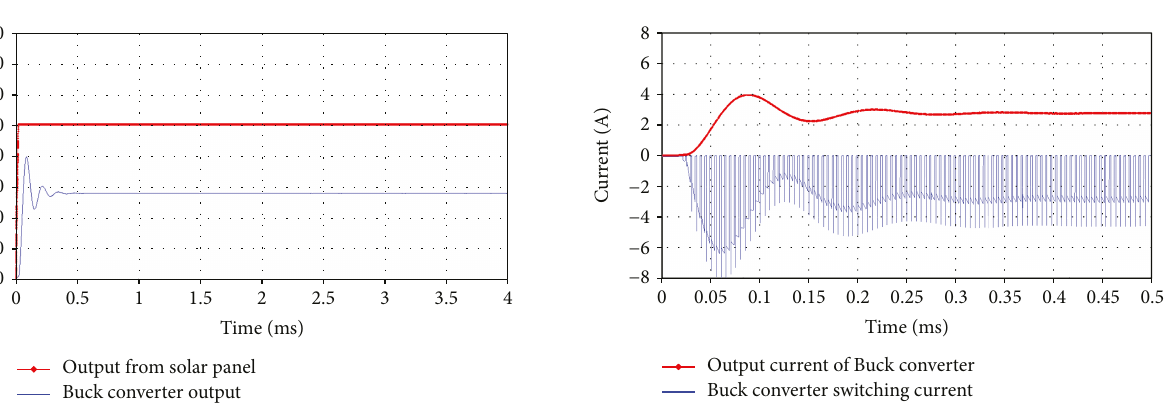
Figure 14: Input and output voltage waveforms for 50V input.